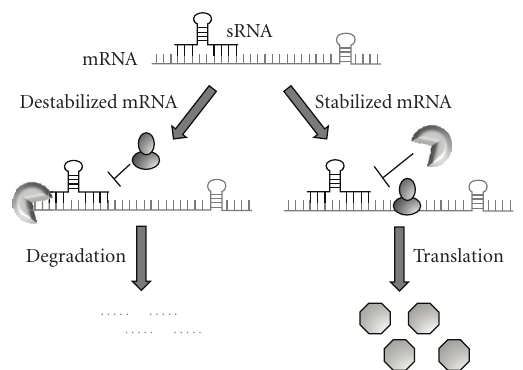
Figure 3: Small RNAs base pair with mRNA targets to a ff ect mRNA stability. Antisense base pairing between sRNAs and their target transcripts mediates mRNA stability by altering the susceptibility of the message to RNases and the translation machinery. Pairing may destabilize mRNA by facilitating RNase-mediated degradation resulting in translation inhibition. In contrast, pairing may stabilize mRNA by inhibiting RNase-mediated degradation resulting in translation of the message and increased protein